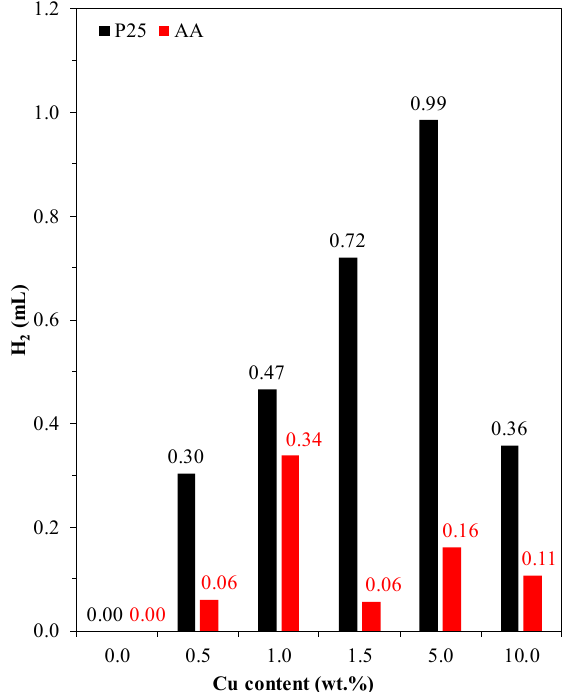
Figure 10. The amount of the generated hydrogen in function of the Cu content of the composites and the base photocatalyst.